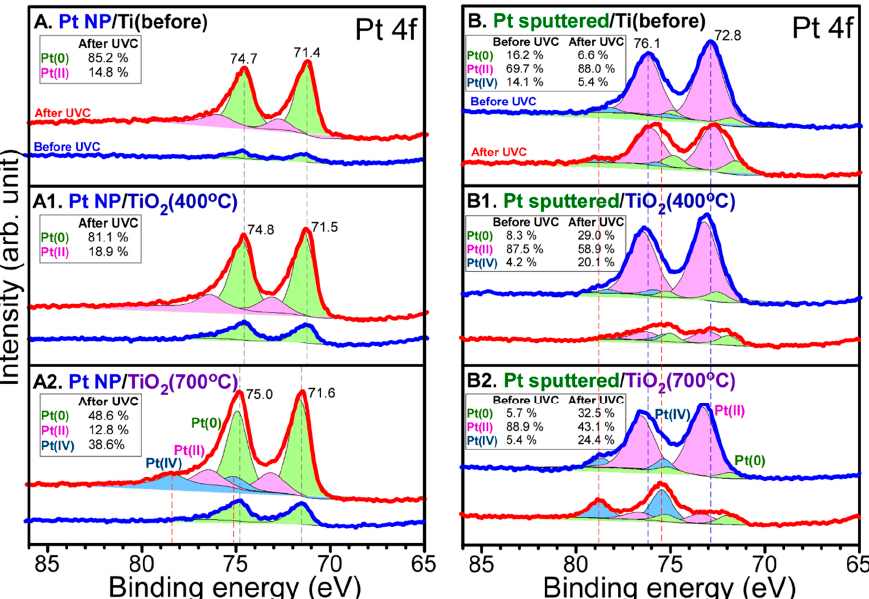
Figure 6. Pt 4f XPS of: ( A ) Pt NP / Ti; ( A1 ) Pt NP / Ti (400 ◦ C); ( A2 ) Pt NP / Ti (700 ◦ C); ( B ) Pt-sp / Ti; ( B1 ) Pt-sp / Ti (400 ◦ C); ( B2 ) Pt-sp / Ti (700 ◦ C) samples before (blue) and after (red) CO 2 reduction. Inset tables show relative ratios of the deconvoluted peaks.